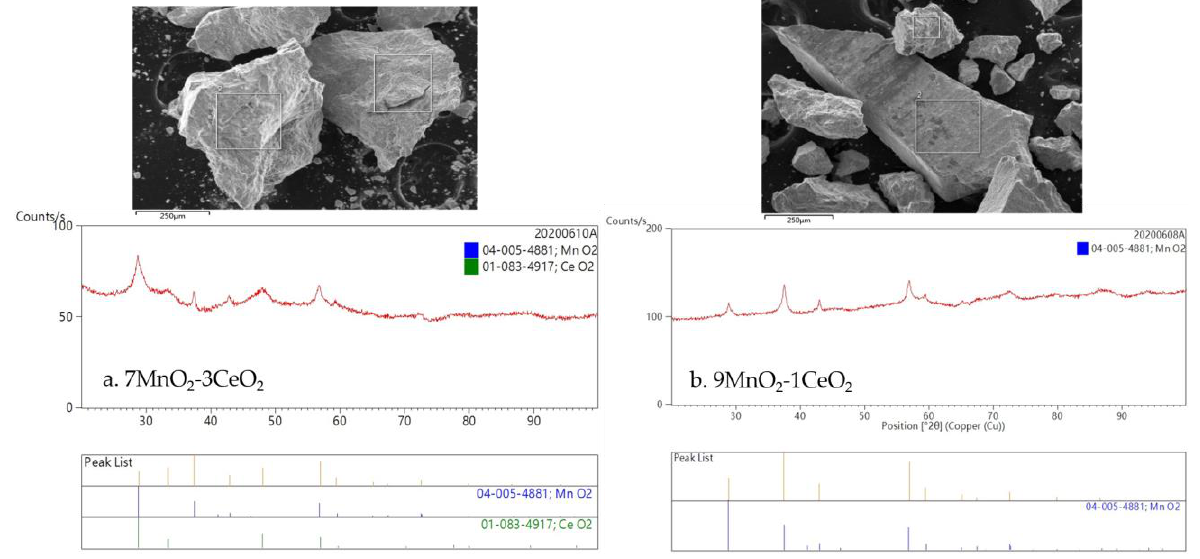
Figure 3. SEM images and XRD patterns of ( a ) 7MnO 2 – 3CeO 2 and ( b ) 9MnO 2 – 1CeO 2 catalysts.